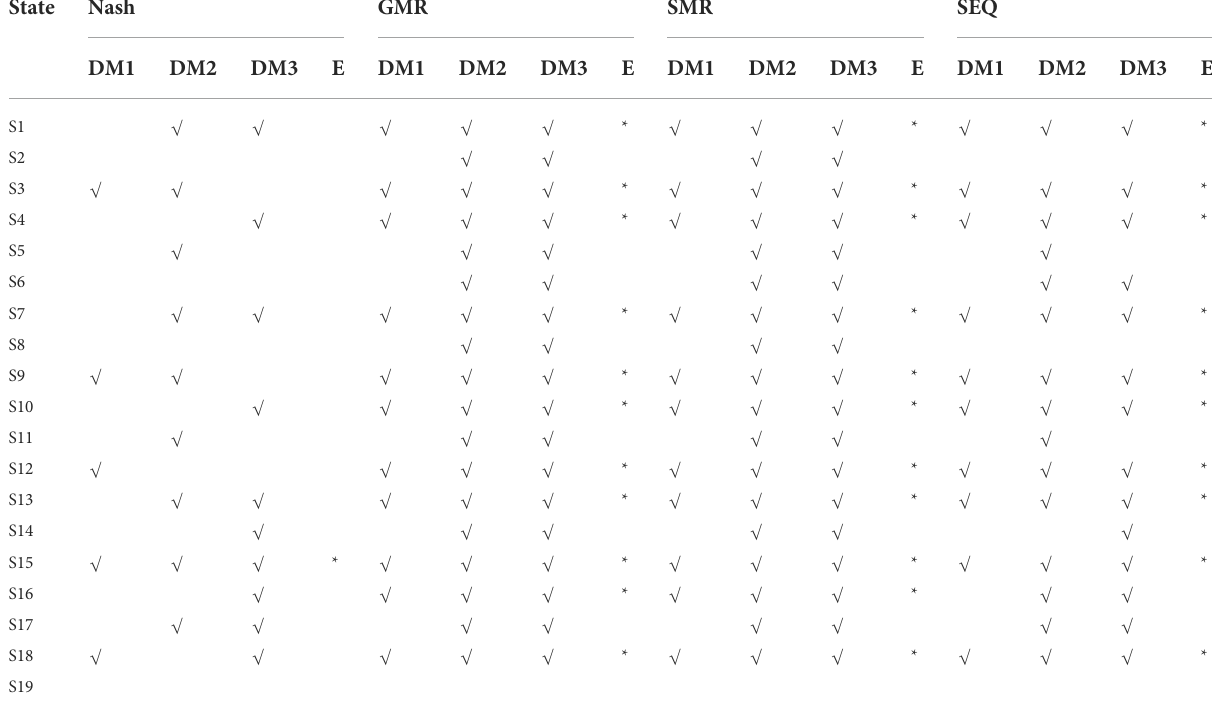
TABLE 3 Stability analysis results of forest tourism development con fl